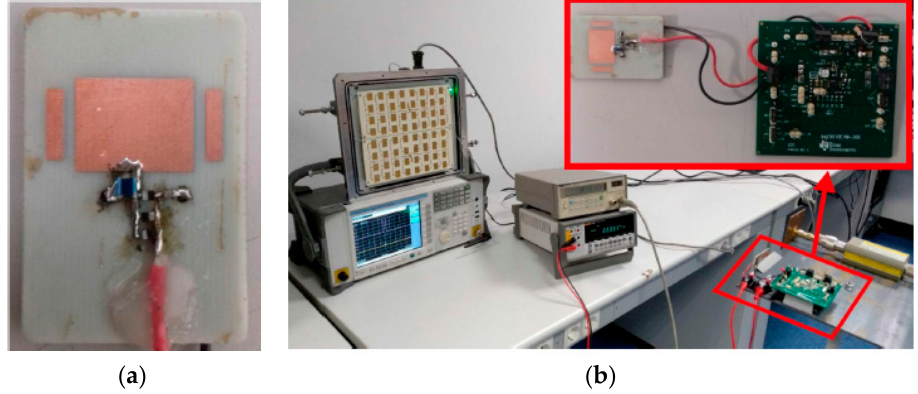
Figure 12. The proposed harvester prototype ( a ) and the experimental setup ( b ) used for the validation. The harvester prototype connected to the DC/DC boost is also highlighted.